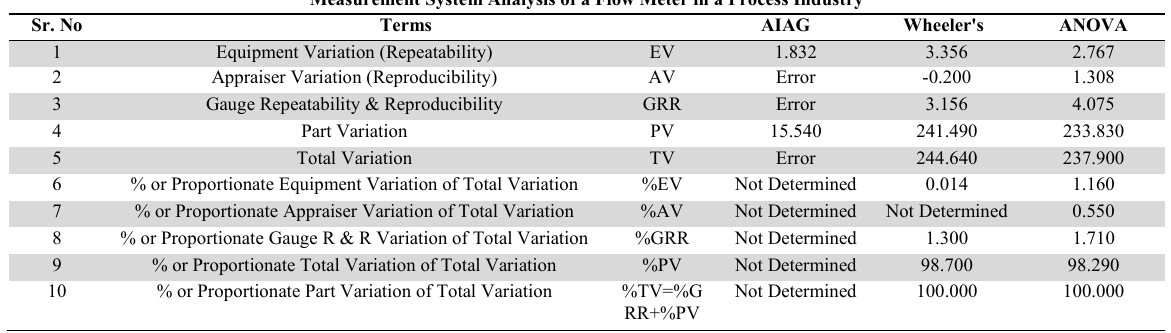
Comparison Sheet of Various MSA Methods Measurement System Analysis of a Flow Meter in a Process Industry